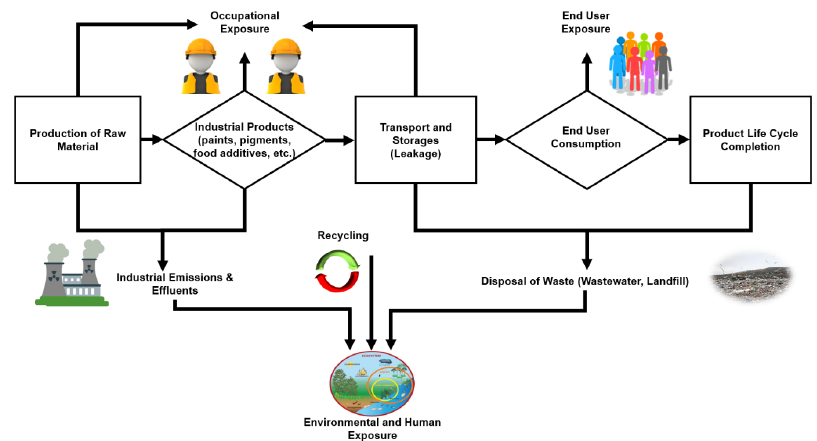
Figure 5. Probable routes of human and environmental exposure.